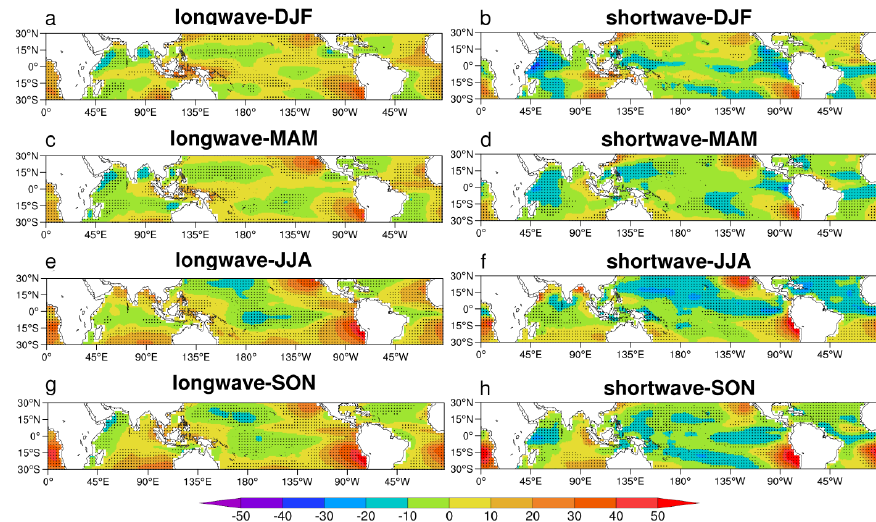
Figure 6. Seasonal mean bias of the model ensemble in (left) longwave ( Q LW ) and (right) shortwave ( Q SW ). Dotted areas indicate where the bias is statistically significant at the 95% level. (unit: W m − 2 ). Table 2. The seasonal and annual mean of Q LW and Q SW from the model ensemble and their bias compared to the OAFlux (1979–2000) and moored buoys (1997–2008). Comparison with the OAFlux was made over 30 ◦ S–30 ◦ N and 10 ◦ S–10 ◦ N (parentheses). The values were written to the closest W m − 2